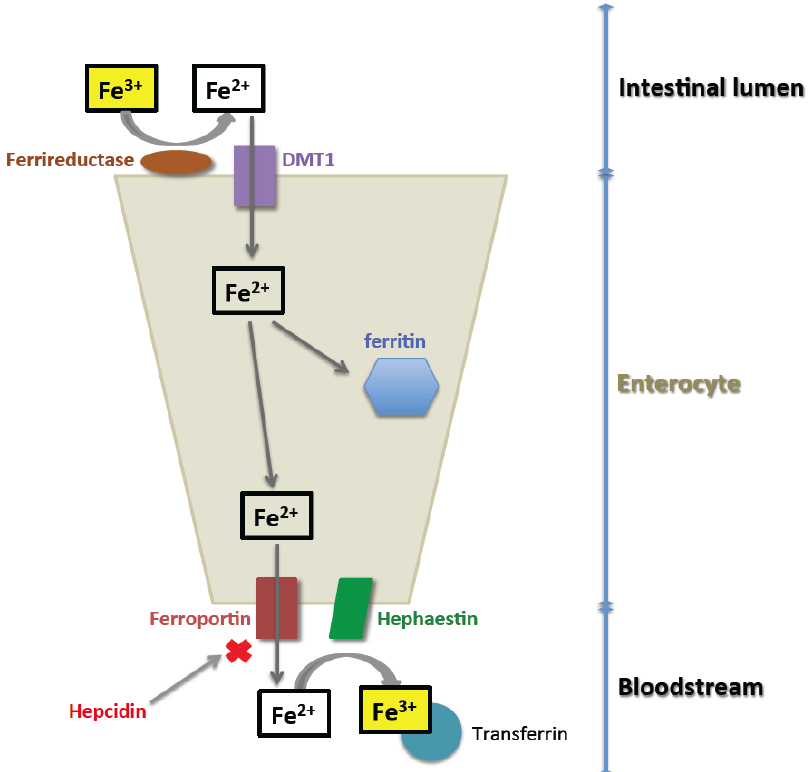
Figure 1. Intestinal absorption of iron. Ferric (Fe 3+ ) iron present in the intestinal lumen is reduced to ferrous (Fe 2+ ) iron, which can be transported by DMT1 across the apical surface of the enterocyte. Intracellular iron may be stored in ferritin, or transported out of the cell via ferroportin. After its release from the cell, it is oxidized by hephaestin and bound to transferrin for transport through the